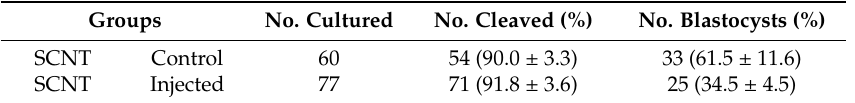
respectively). SCNT: somatic cell nuclear transfer.